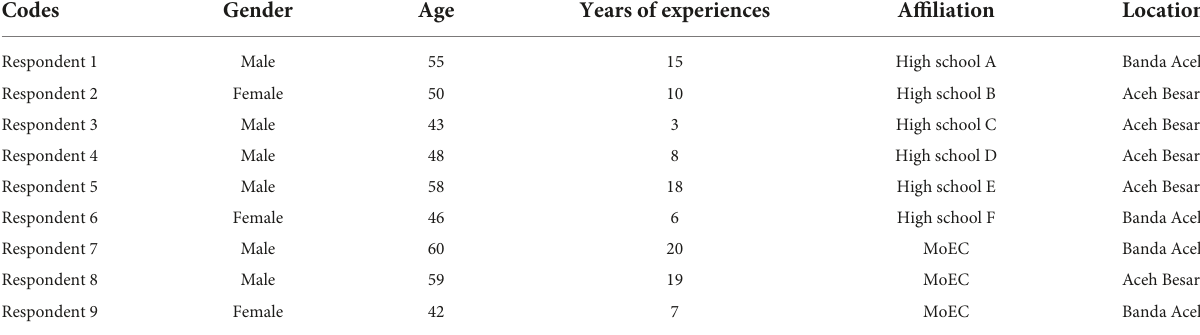
TABLE 1 Characteristics of respondents.